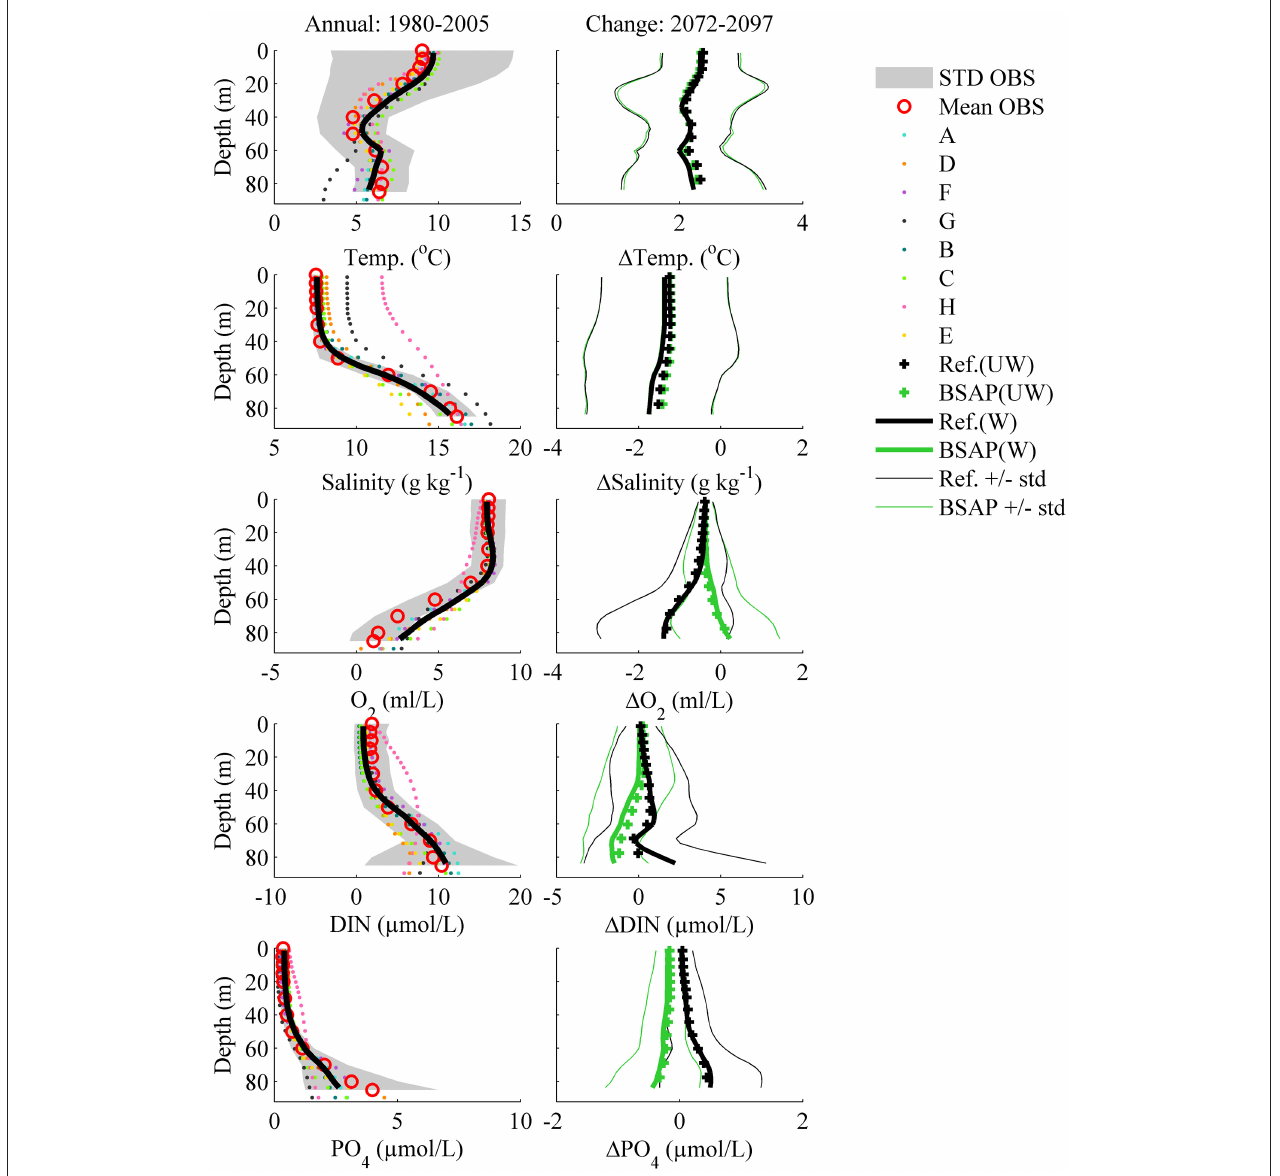
FIGURE 9 | Mean observed and simulated profiles in the control runs for each variable and each Model A to H at Bornholm Deep (BY5) for the period 1980–2005 (left panels). The ensemble mean value (thick black line) is calculated from the weighted model results. In addition, the unweighted (plus signs) and weighted (thick solid lines) ensemble mean changes and standard deviations between the future (2072–2097) and present (1980–2005) climates in REF and BSAP scenario simulations are shown (right panels). Standard deviations are calculated from the two ensembles without